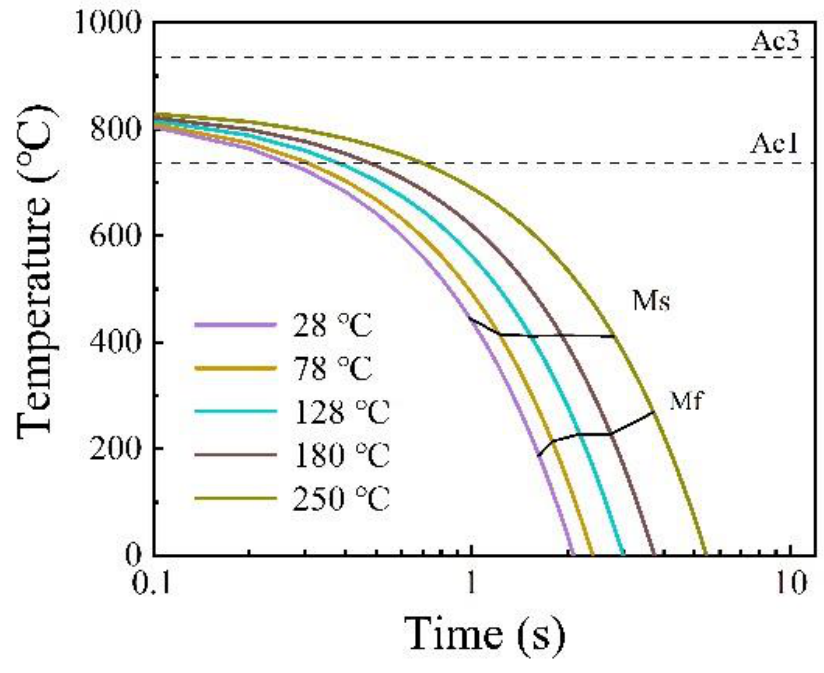
Figure 10. CCT diagram of AH36.